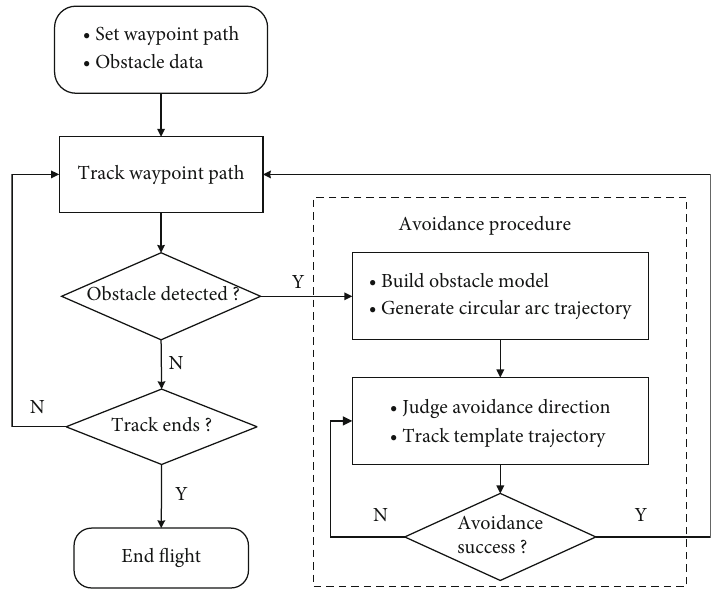
Figure 7: UAV guidance procedure.